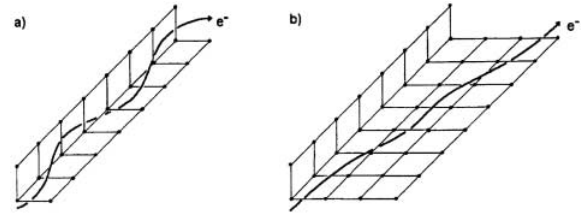
1098-4402 (cid:2) 02 (cid:2) 5(7) (cid:2)